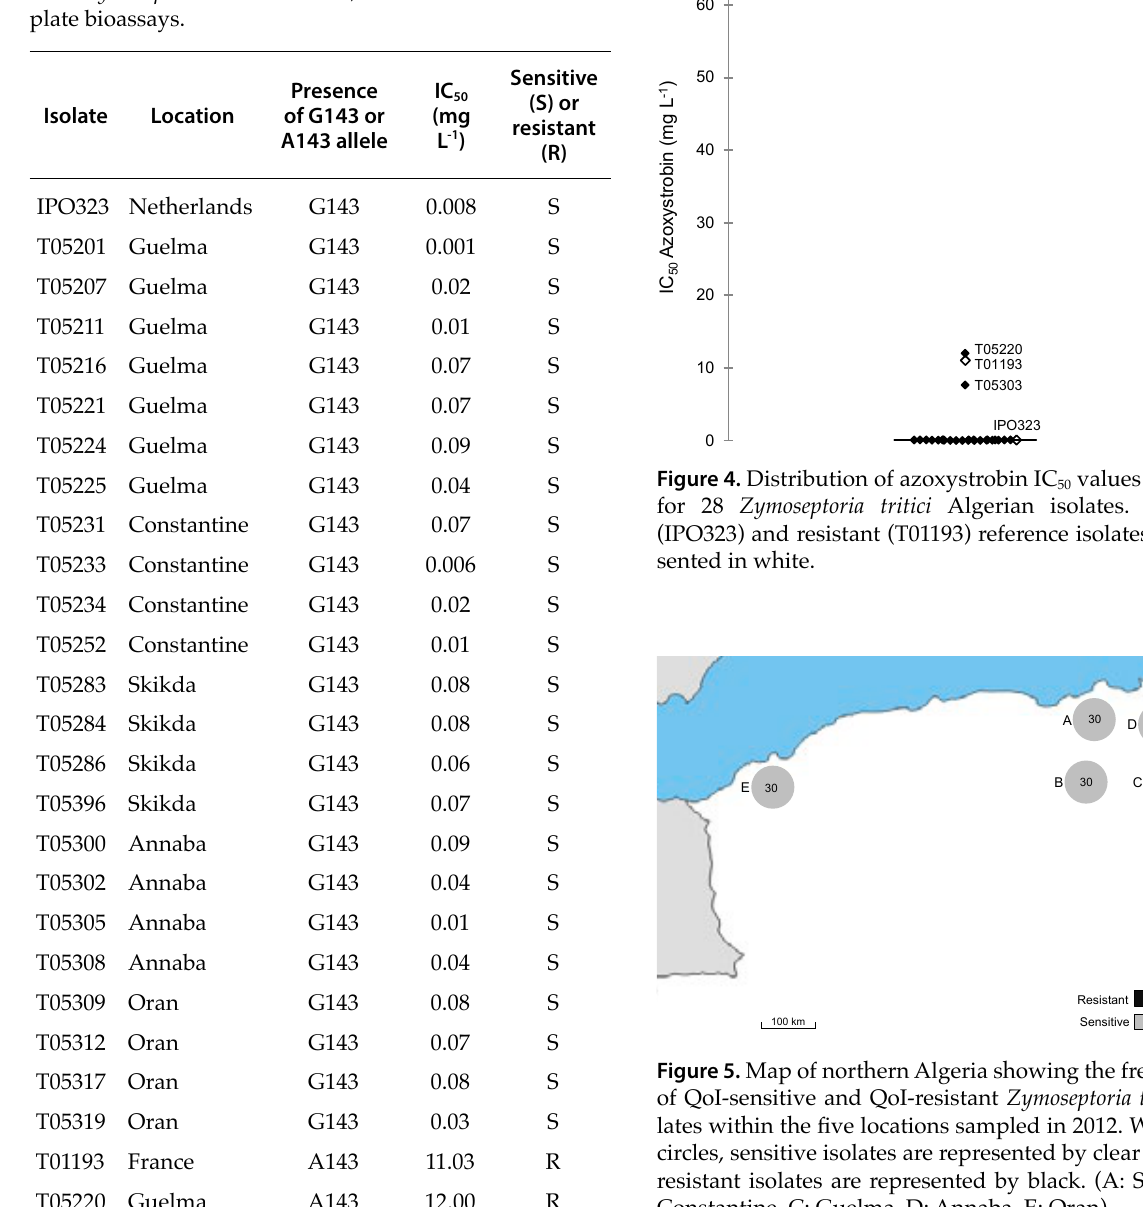
Figure 5. Map of northern Algeria showing the frequencies of QoI-sensitive and QoI-resistant Zymoseptoria tritici iso- lates within the five locations sampled in 2012. Within the circles, sensitive isolates are represented by clear grey and resistant isolates are represented by black. (A: Skikda, B: Constantine, C: Guelma, D: Annaba, E: Oran).